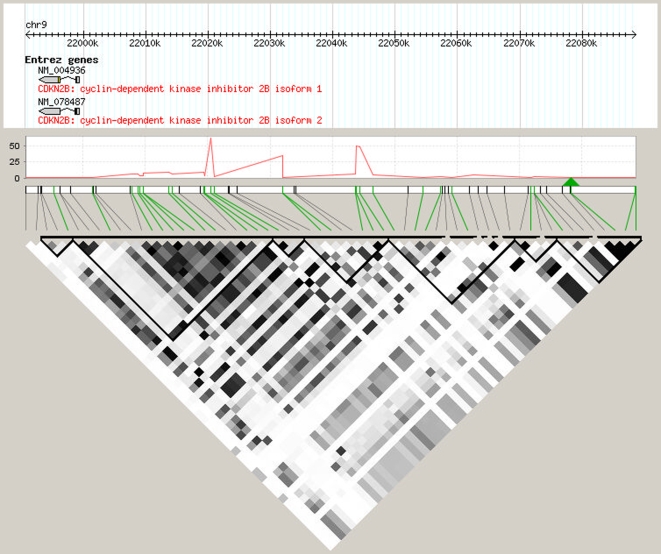
The loci affecting CDKN2B expression and CAD on chromosome 9p21 are independent.The lead SNP rs1333049 generally reported at the CAD locus was not present on the Affymetrix 6.0 array, we therefore selected its best proxy, rs10757272 (position 22078260, r2 = 0.9 with rs1333049), using SNAP (https://www.broadinstitute.org/mpg/snap). Positions of genotyped SNPs are shown using a green link and position of the proxy SNP, rs10757272, is represented by a green triangle. The red curve reflect the –log10(P-value) for the association between SNPs and CDKN2B expression. The LD (r2) between pairs of SNPs is shown at the bottom of the figure using a range of colors between white (r2 = 0) and black (r2 = 1). The CDKN2B and CAD-associated SNPs are located in different blocks of LD strongly suggesting that the genetic effects on CDKN2B expression and CAD are independent.